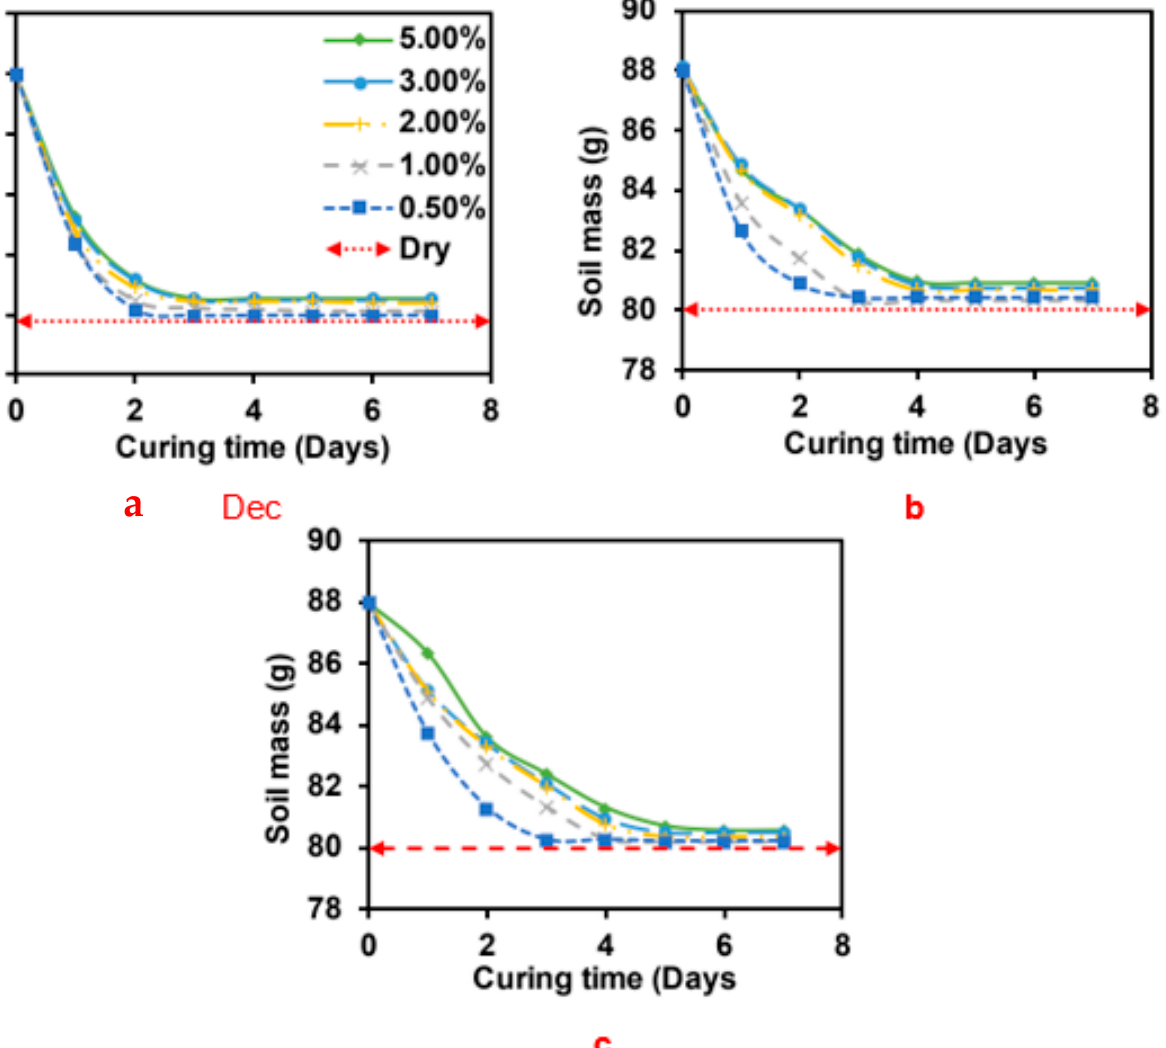
Figure 9. Variation of moisture content of soil specimen modified with 2% concentration of ( a ) Acacia, ( b ) Sodium alginate, and ( c ) Pectin.